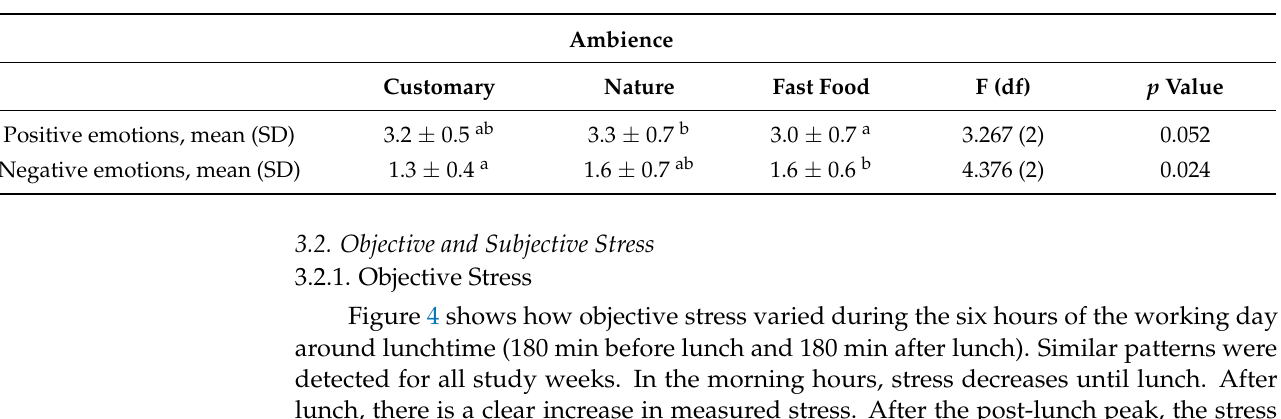
Table 1. Positive and negative emotions evoked by the lunch experience on a scale in which 1 = low intensity and 5 = high intensity. Data from the subgroup of participants ( n = 32). The different letters next to the means indicate statistically significant difference ( p ≤ 0.1) between the study weeks.